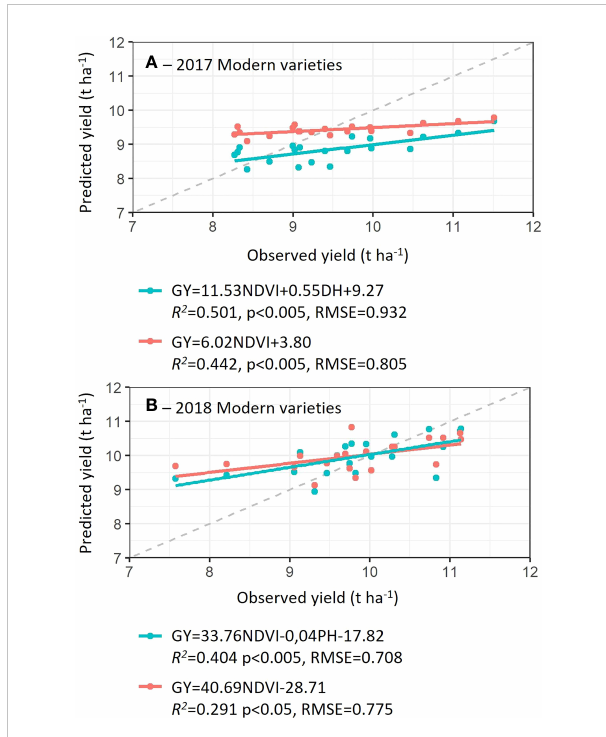
FIGURE 4 Prediction accuracies (coef fi cients of determination, R 2 ), root means square root (RMSE) and probability of models developed with 50 data points from Case Study 1 using modern varieties in 2017 (A) and 2018 (B) . Predicted yield values were calculated in 20 plots not used in the development of models (irrigated and optimal sowing date). Dashed line indicates a 1:1